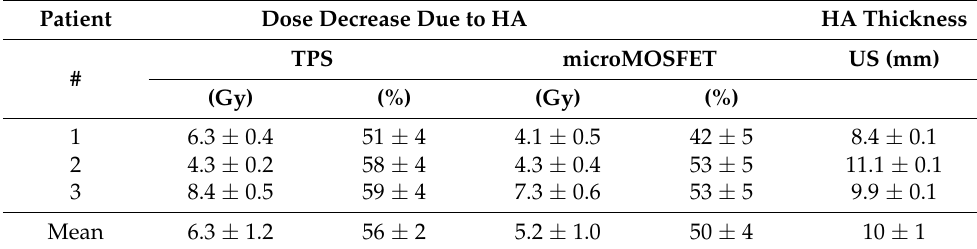
of HA, in the neurovascular bundle for each of the patients studied. The value of the decrease in absorbed dose calculated by treatment planning system (TPS) appears in the second (Gy) and the third (%) column, the value the decrease in absorbed dose measured by microMOSFET detector appears in the fourth (Gy) and the fifth (%) column, and HA thickness measured in the ultrasound (US) image appears in the sixth (mm)